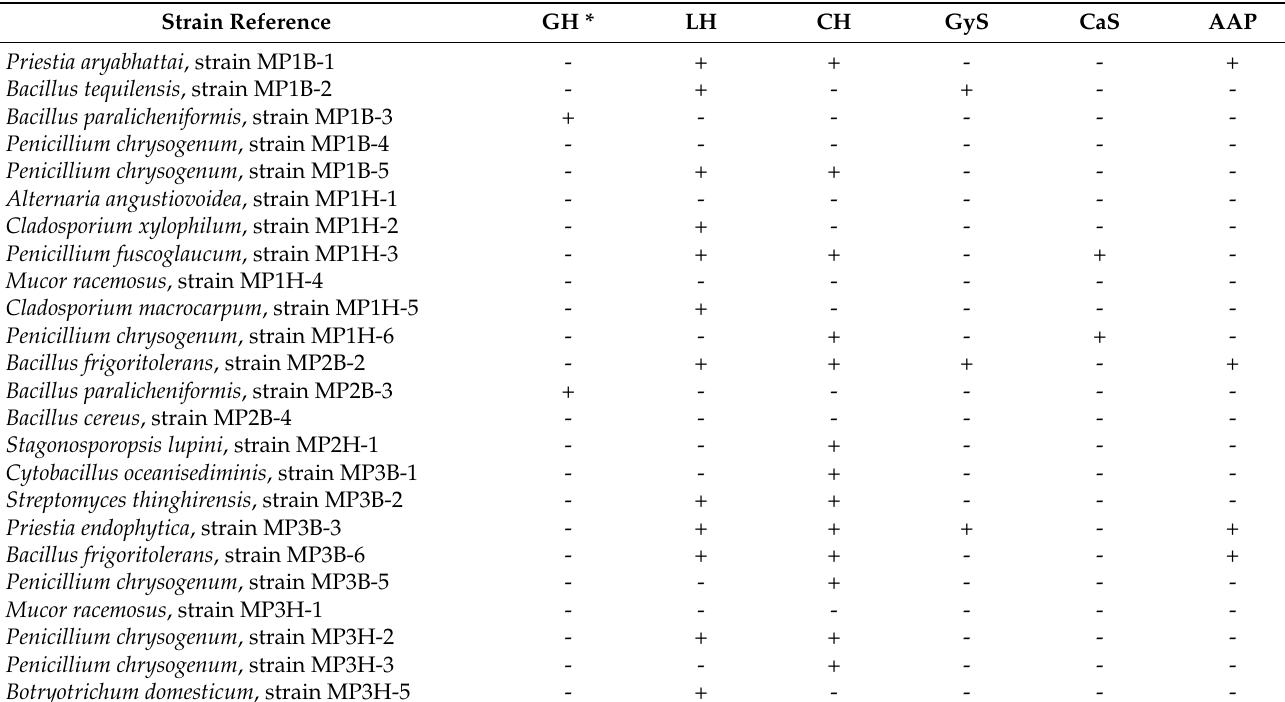
Table 5. Microbial activities of bacteria and fungi isolated from Sal ó n de Reinos